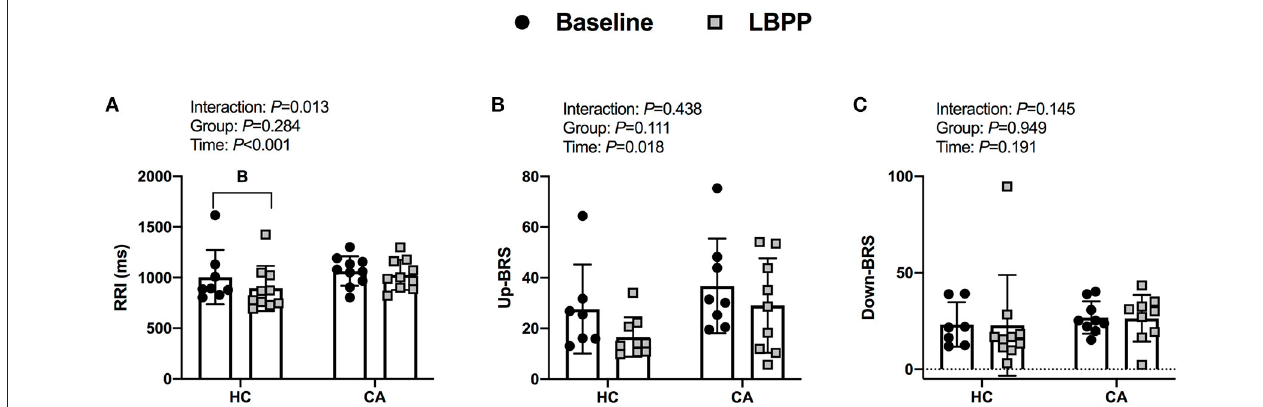
FIGURE 7 | Indices of cardiac-baroreflex sensitivity for Healthy Controls and Concussed Athletes at baseline and LBPP. B, different from Baseline, ( P ≤ 0.05).